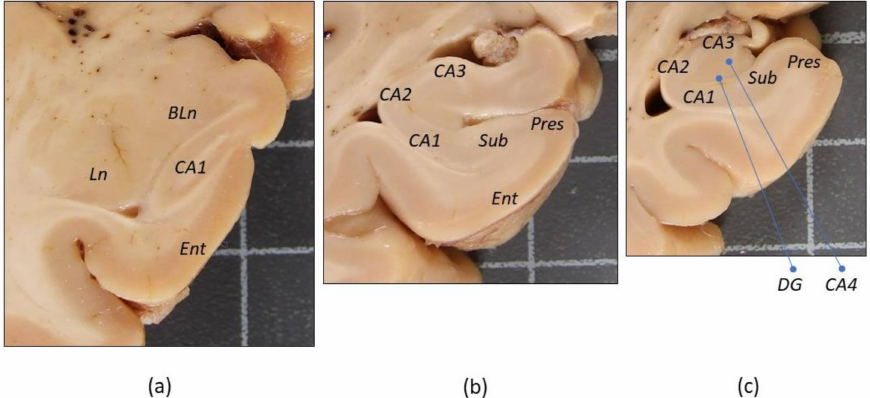
Figure 1. Macroscopic images of medial temporal lobe coronal sections showing the main anterior– posterior levels and regions of interest assessed in the present study. Photographs correspond to a control brain. ( a ) Amygdala, ( b ) anterior hippocampus (head), and ( c ) posterior hippocampus (body). The location of assessed areas of interest is indicated at each level. BLn , basolateral nuclei, and Ln , lateral nuclei of the amygdala. Ent , entorhinal cortex. Pres , presubiculum. Sub , subiculum. CA1 , CA2 , CA3 and CA4 , Sommer’s sectors of the hippocampus cortex. DG , dentate gyrus. Squares of the background grid are 1 cm in